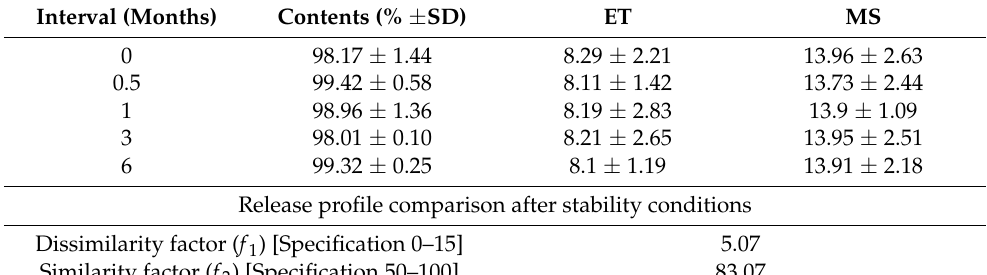
Table 5. Stability data of the optimized formulation under IVa regional guidelines.